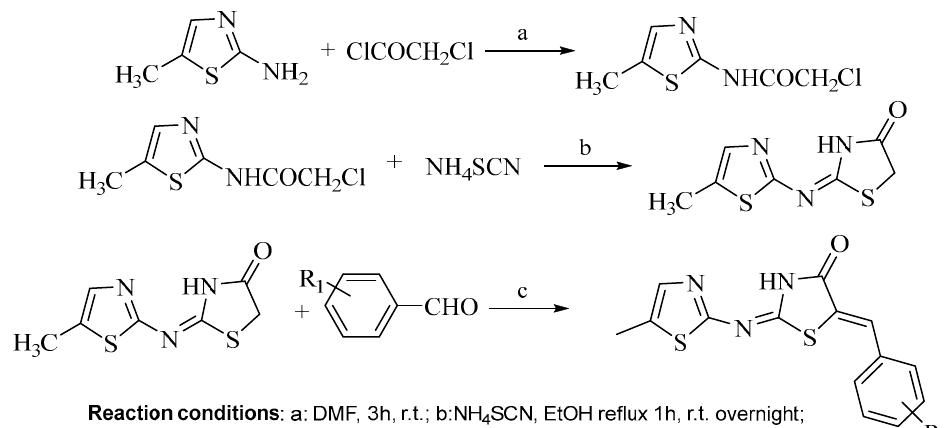
Table 2. Anti-inflammatory activity of titled